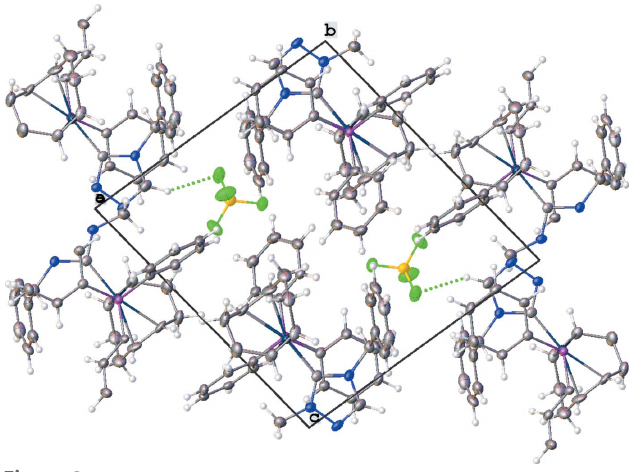
Figure 2 Crystal packing unit-cell diagram of the title compound ( 4 ). Non-covalent interactions are shown as dotted green lines.